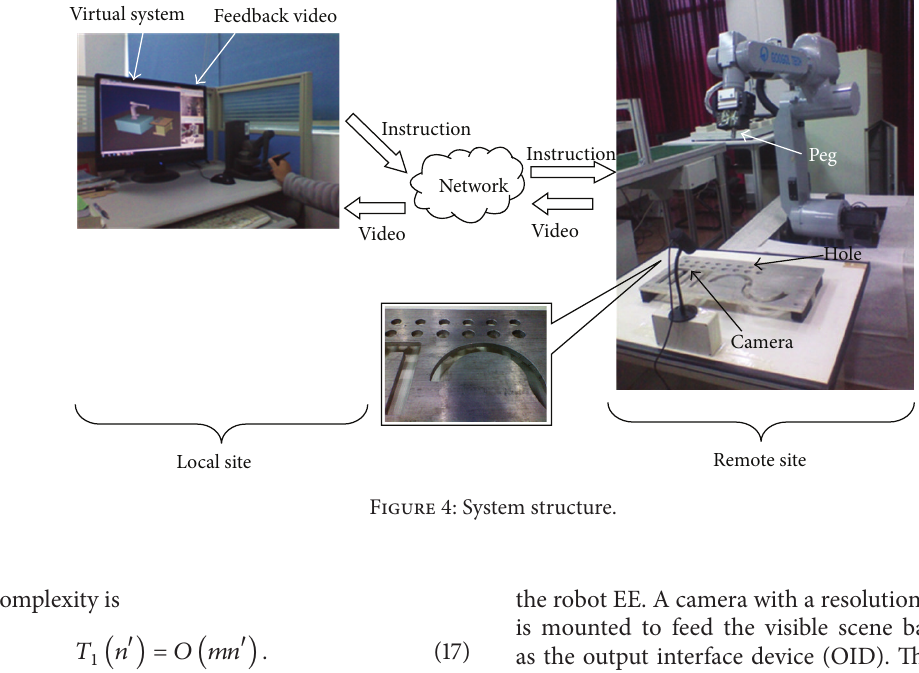
Figure 4: System